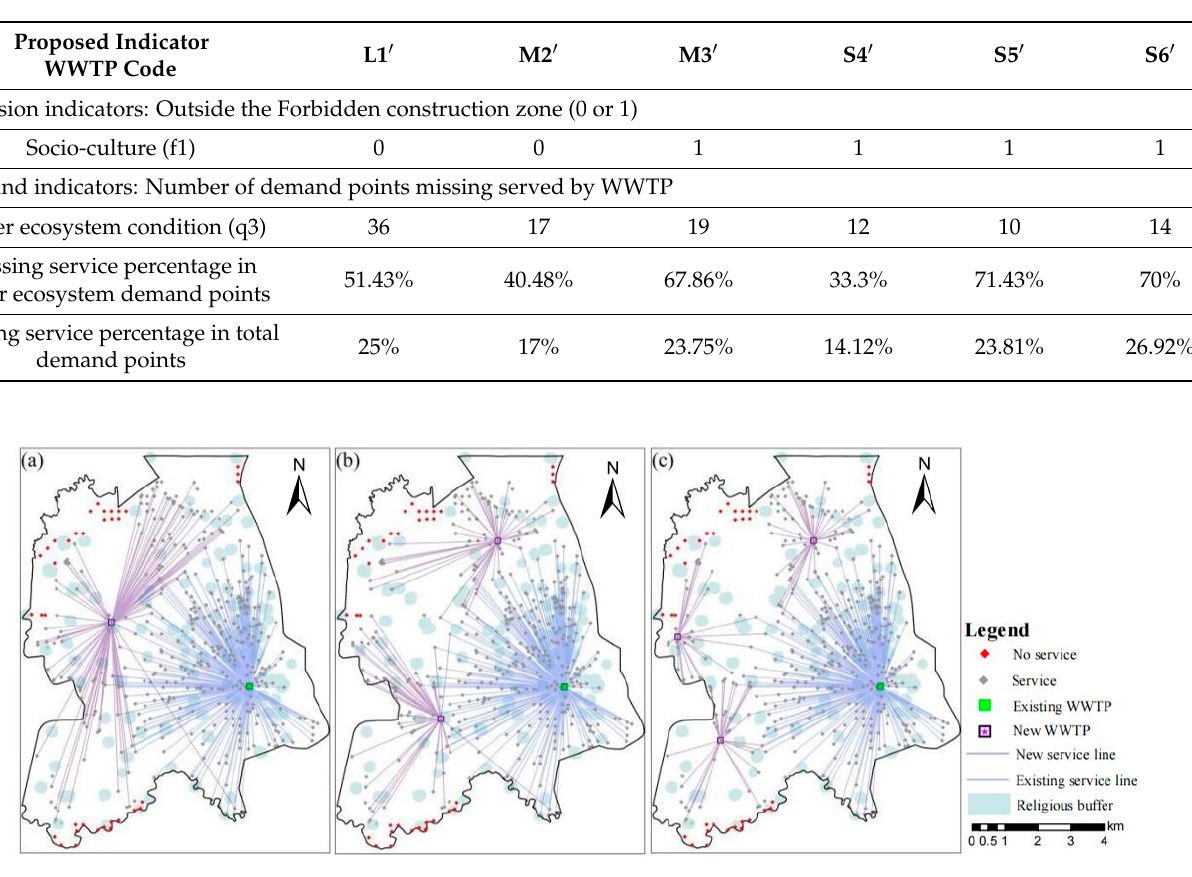
Figure 13. Distribution of WWTPs without considering the indicator system proposed in this paper: ( a ) One large WWTP; ( b ) Two medium WWTP; ( c ) Three small